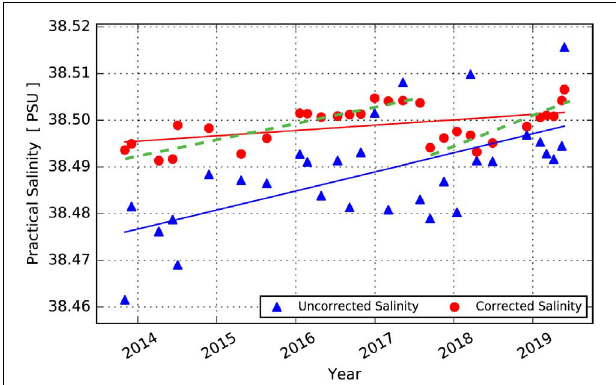
FIGURE 5 | Mean salinity between potential temperatures 12.90 and 13.00 ( ◦ C) for each glider mission, for uncorrected glider data (blue), and DM field corrected glider data (red).